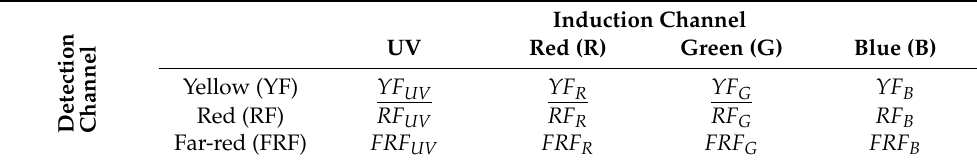
Table 2. Presentation of the nine fluorescence and two reflectance (underlined) signals acquired by the Multiplex MX3 at each reading. Subscripts indicate the induction